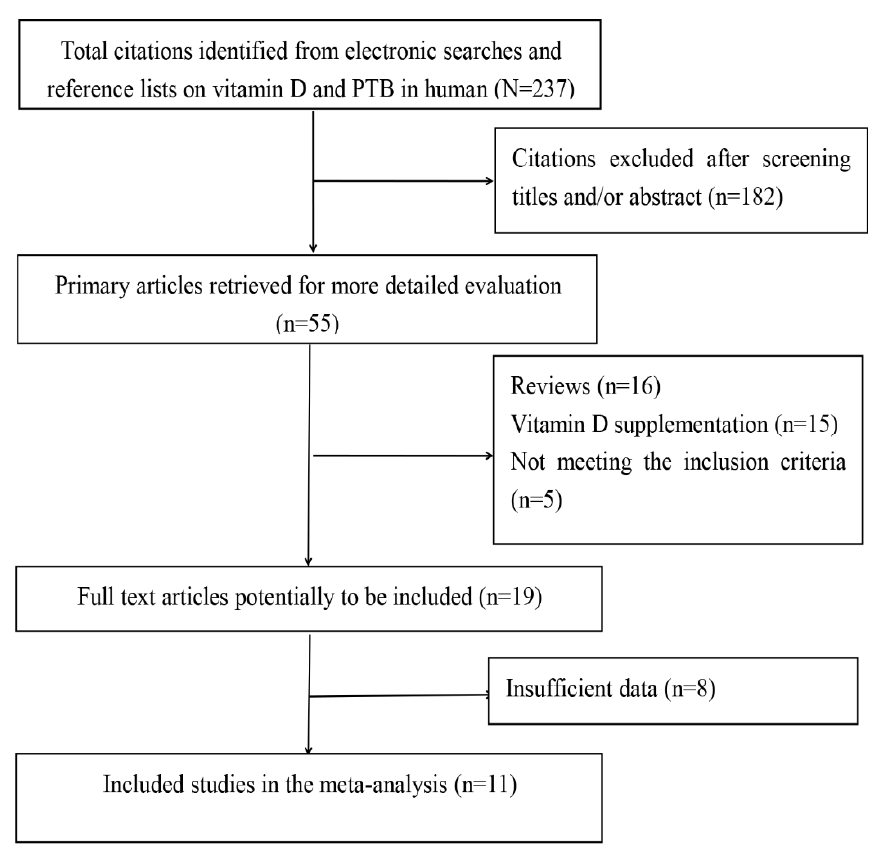
Figure 1. Flow chart of literature search and study selection.